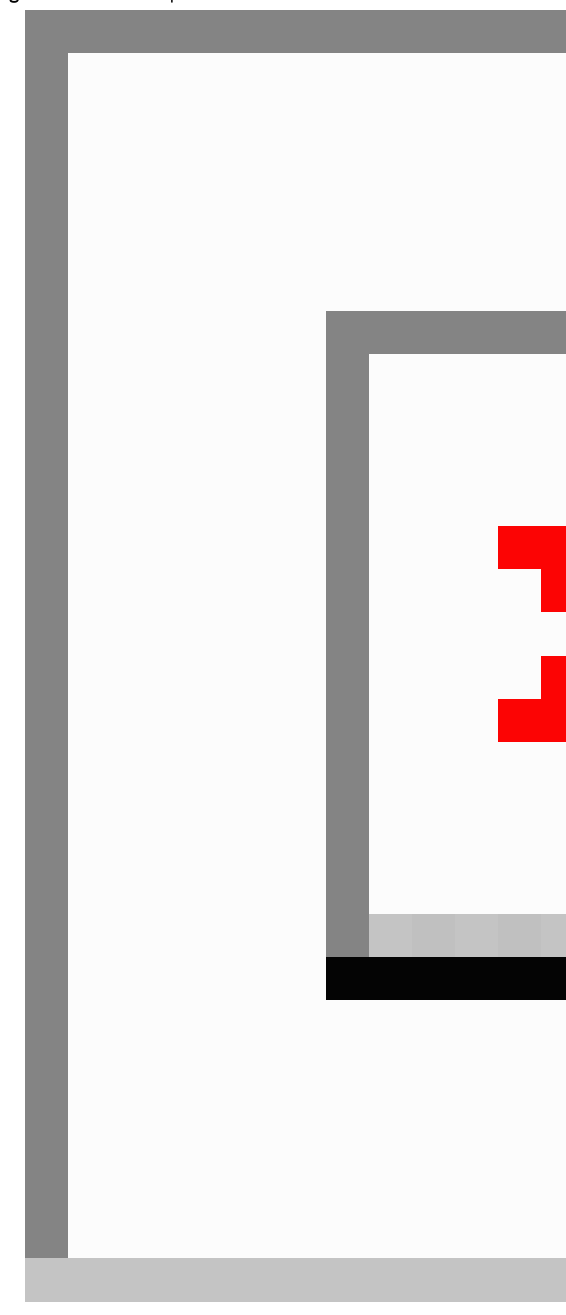
Figure 3. Out-of-sequence